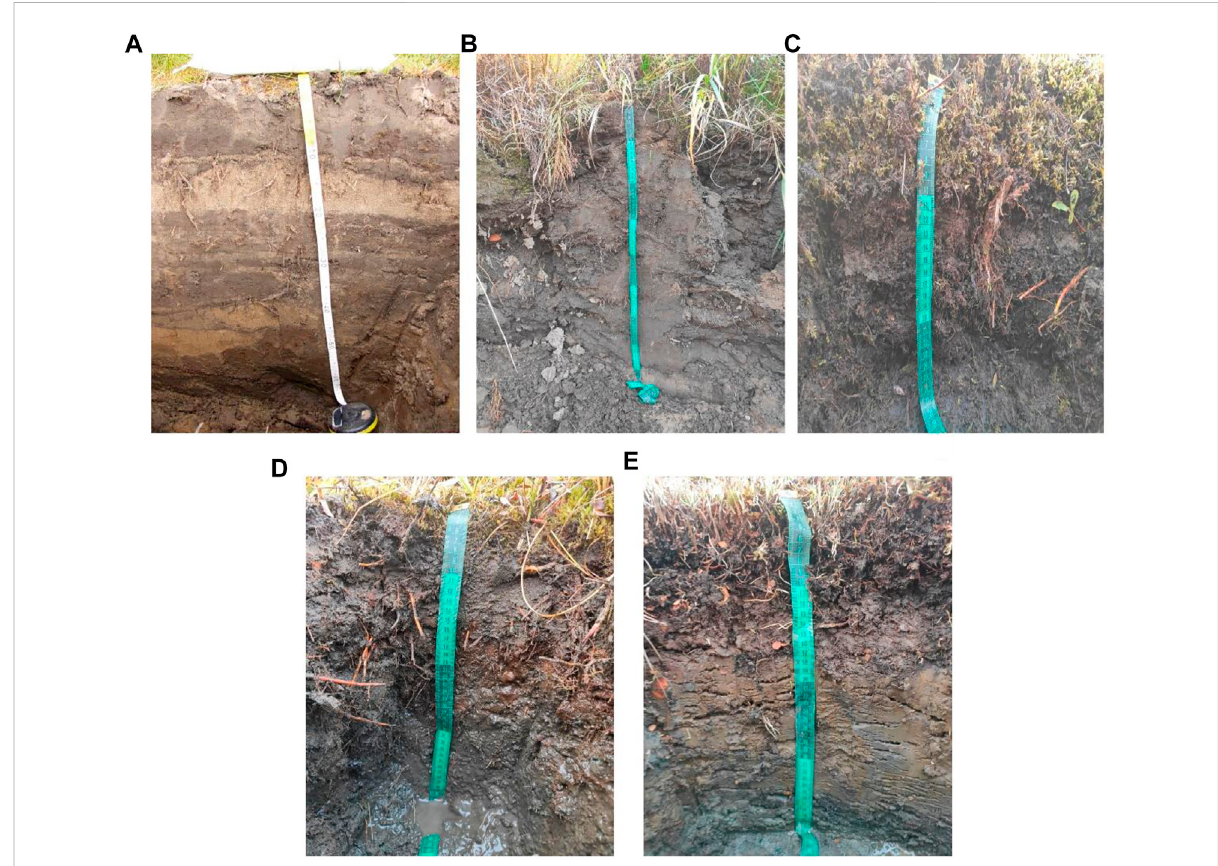
FIGURE 2 Soil distribution in the Samoylov isl. (A) Subaquatic Fluvisol (Arenic); (B) Folic Podzol (Oxyaquic); (C) Epicryic Histosol; (D) Reductaquic Cryosol (Siltic); (E) Folic Cryosol